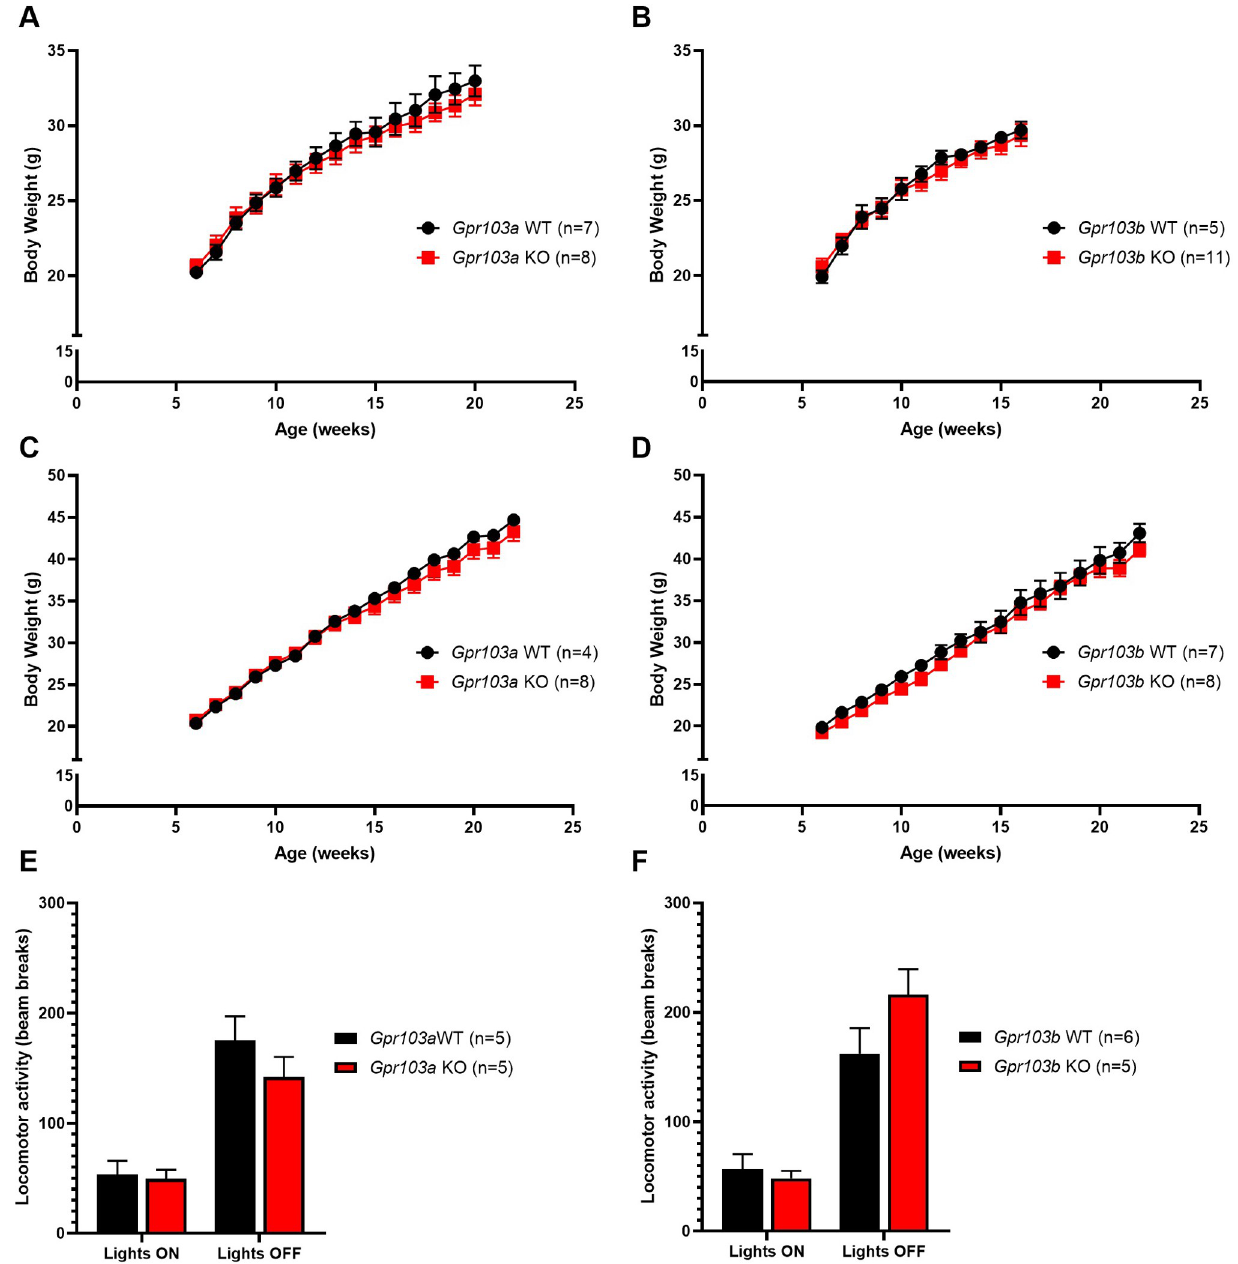
Fig 3. Germline deletion of Gpr103a or Gpr103b does not produce a metabolic phenotype. Growth curves for male Gpr103a knock-out mice and wild- type littermates on (A) normal chow or (B) high-energy diet. (C) Locomotor activity (beam crosses) during the light and dark phases in Gpr103a knock- out mice and wild-type littermates. (D and E) Growth curves for Gpr103b knock-out mice and wild-type littermates on normal chow or high-energy diet. (F) Locomotor activity in Gpr103b knock-out mice.